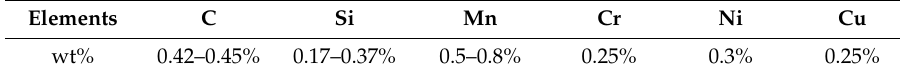
Table 6. Chemical composition of AISI 1045 steel (wt%).